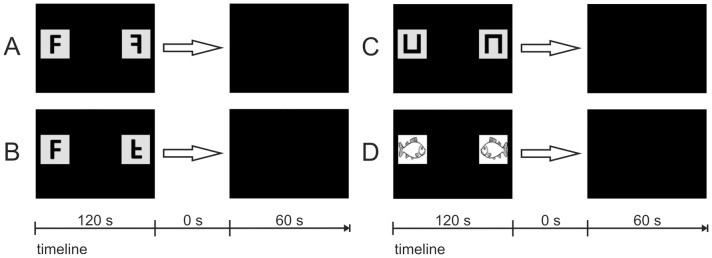
Chronology of the sequences of PowerPoint slides used in the different steps of experiment 2a.The positive stimulus is shown on the left. The timeline indicates the duration of each slide's presentation in seconds. The last slide denotes the ITI. (A) The F-shape and its horizontal mirror-image. (B) The F-shape and its vertical mirror-image. (C) The U-shape and its vertical mirror-image. (D) The ‘fish’ stimulus and its horizontal mirror-image.